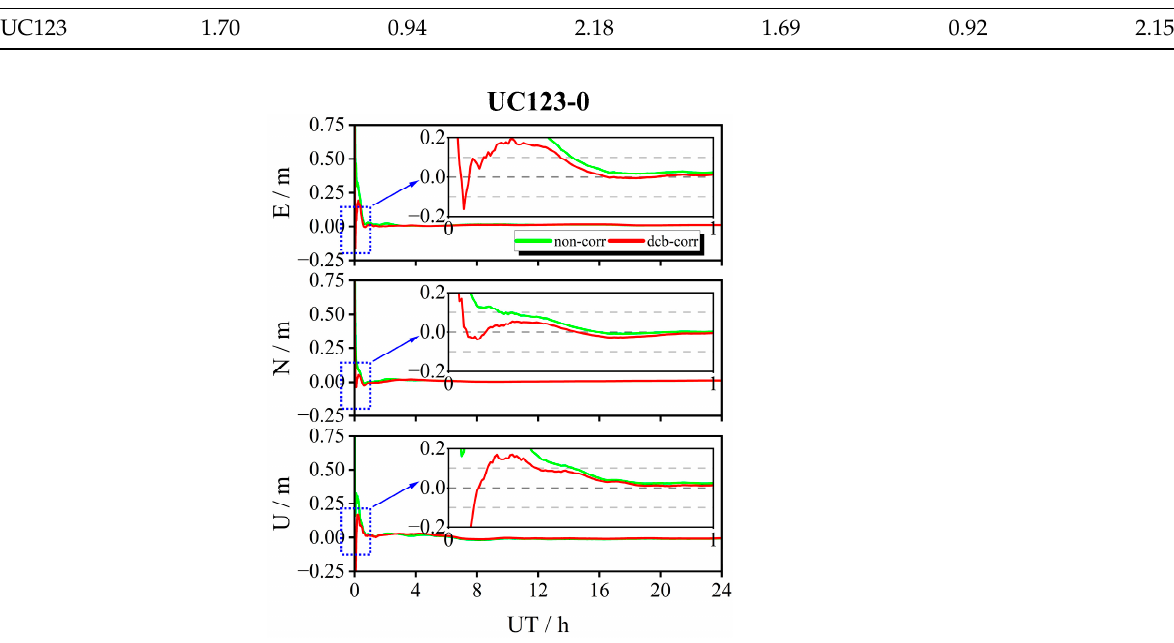
11. UC123 corrected by DCB shows significant accuracy improvement in the E, N and U the convergence time, the dcb-corr of UC123-0~UC123-3 all show an improvement